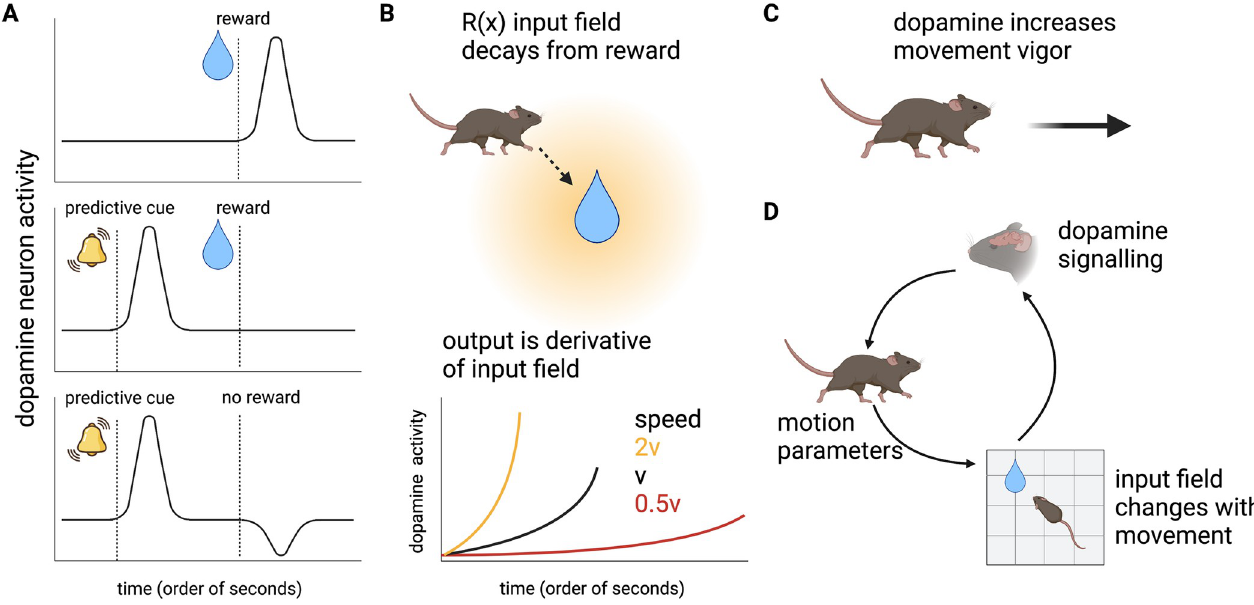
Fig 1. Experimental observations on dopamine imply feedback between motion and sensing. (A) Dopamine responses represent predictions errors over expected rewards, as observed in the classical experiments of Schultz [28]. Dopaminergic neurons fire at a constant rate of ~4-5Hz, and the delivery of a reward causes them to fire over this baseline rate (upper panel); however, when reward delivery is preceded by a predictive cue, the increase in firing occurs following the cue, and there is no increase following reward delivery (middle panel). Dopaminergic neurons fire below their baseline following the omission of an expected reward (lower panel). (B) As the animal approaches a reward, dopamine activity may increase, a phenomenon known as dopamine ramps. In elegant experiments based on virtual reality manipulations of animal movement (including change of movement velocity and teleportation), Kim et al. [12] demonstrated that dopamine ramps correspond to a temporal derivative calculation over a spatial input field that decays away from the reward. Thus, for example, movement at higher velocity leads to higher dopamine levels. (C) Finally, higher dopamine levels increase movement vigor. (D) There is thus feedback between dopamine sensing and movement–the movement of the animal (including movement velocity) changes the temporal derivative of the sensed input field, which affects dopamine levels, which then feed back on movement parameters. Figures were created with